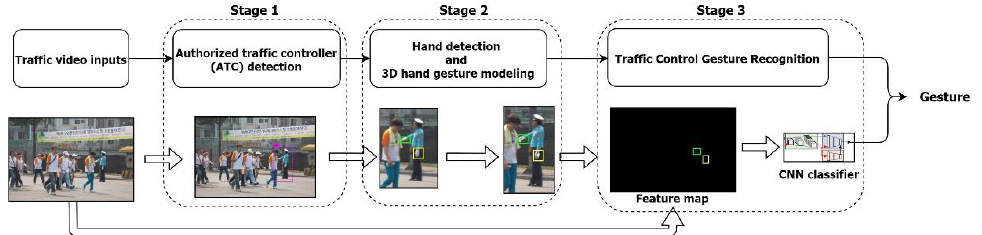
Figure 5. Block diagram of the ATC hand gesture recognition system.